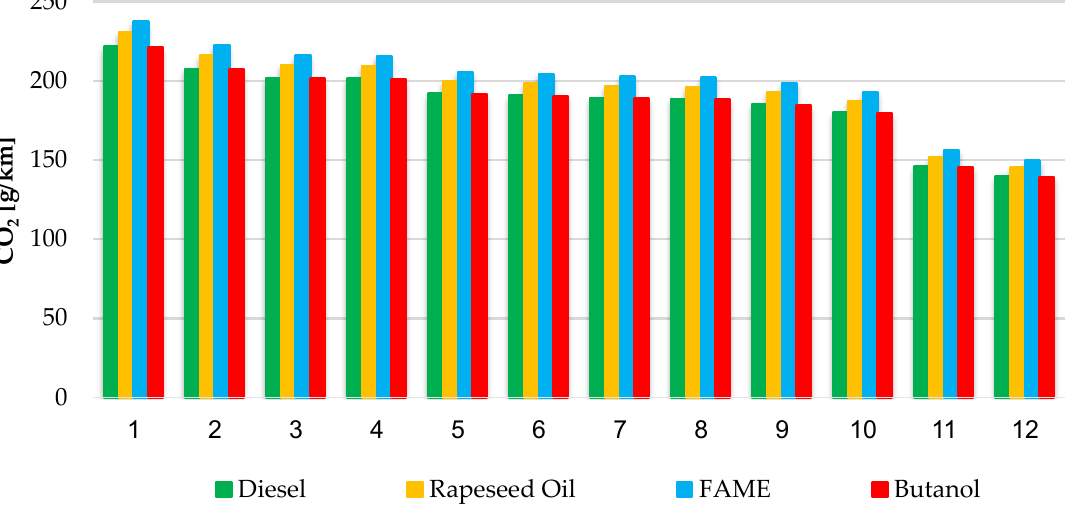
Figure 13. Summary of carbon dioxide emissions in tests per 1 kilometer: 1—Random Cycle High (x95); 2—FTP 75; 3—US SC03; 4—US 06; 5—NEDC; 6—CADC; 7—WLTC 3b random; 8—CADC without MOT; 9—CADC shortened; 10—Random Cycle Low (x05); 11—MAC TP cycle; 12—US highway.